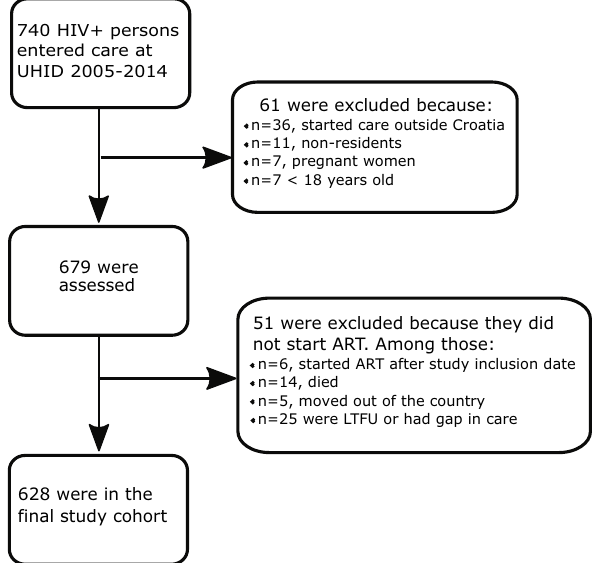
Figure 4. Flow diagram of participants included into the study. HIV human immunodeficiency virus; UHID University Hospital for Infectious Diseases, Zagreb, Croatia; ART antiretroviral treatment; LTFU lost to